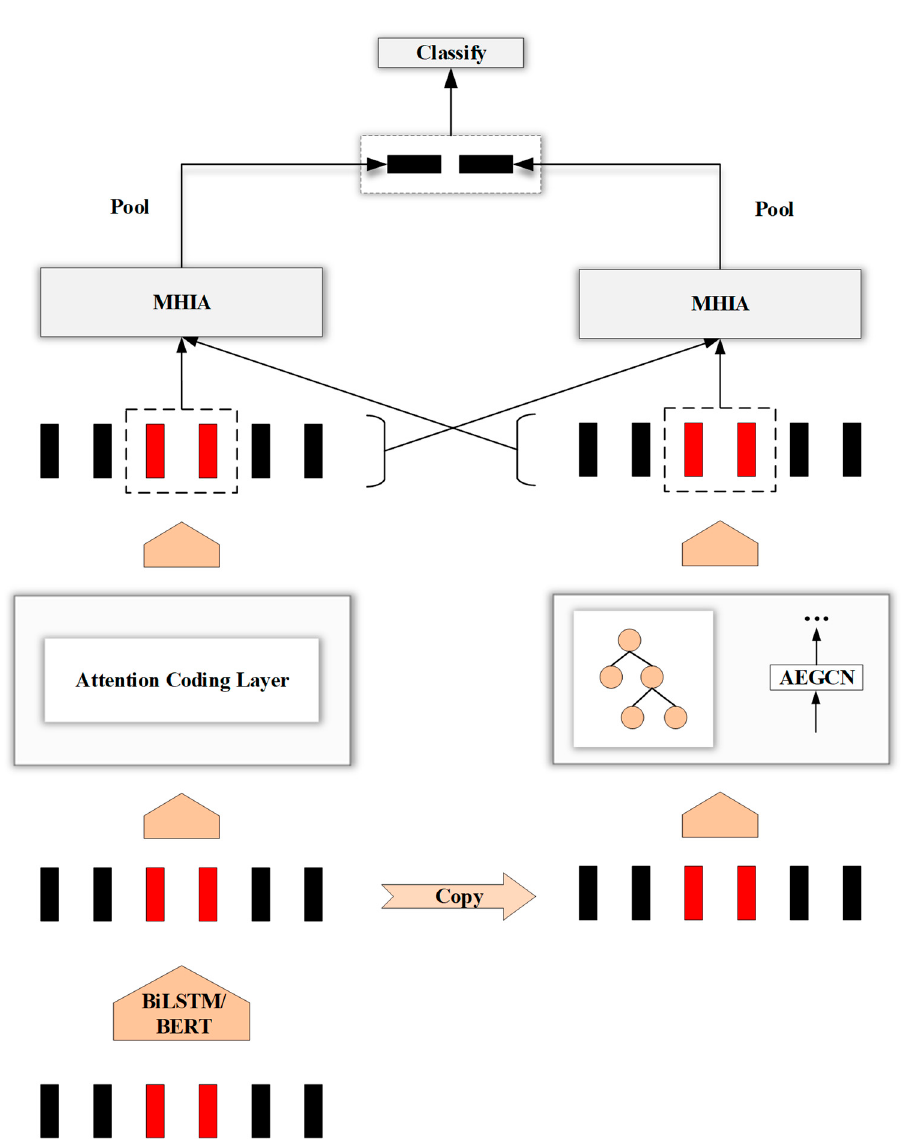
Figure 1. Overview of the proposed model for aspect-based sentiment classification.